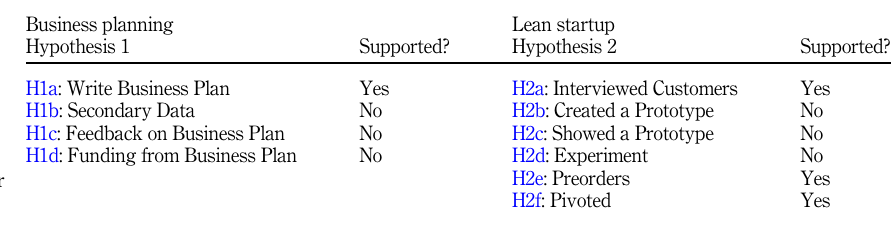
Table 5. Summary findings for DV –